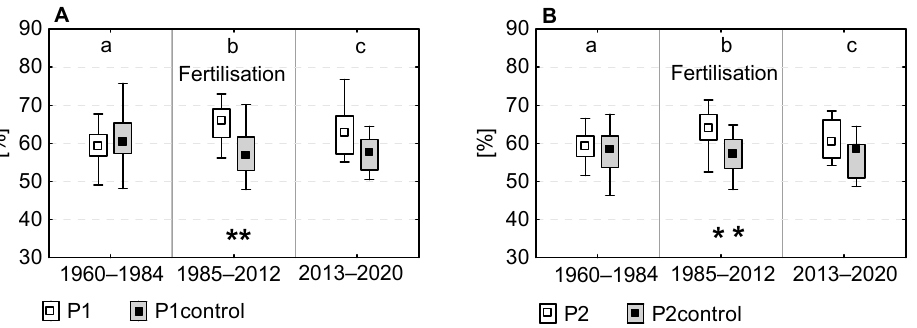
Figure 7. Box plots showing the share of earlywood to total annual ring width of Scots pine on study plots in different tree growth periods, the lowercase letters marked: a—25 years before the start of FWTP activity; b—the period of the FWTP operation (fertilization); c—years after the FWTP was closed. ( A )—plots with younger trees; ( B )—plots with older trees. Asterisks indicate a significant difference between the study and control plots; ** represents that 0 < p -value < 0.01.